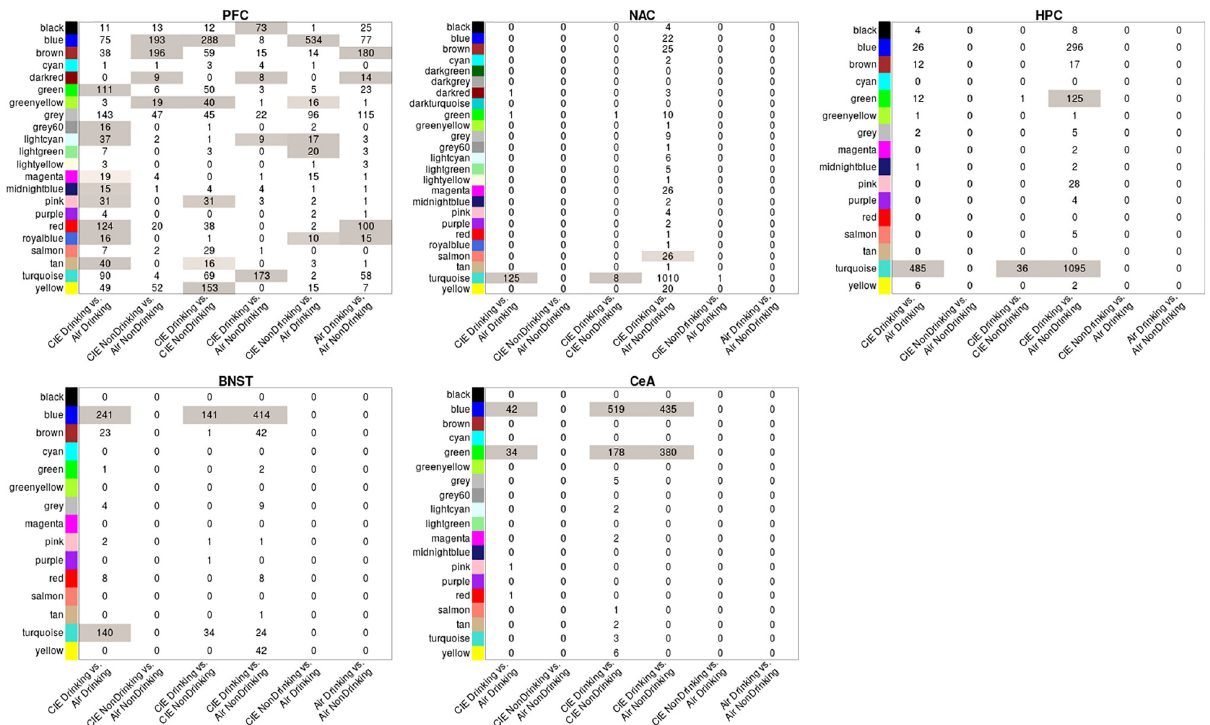
Fig 4. Overlap between WGCNA modules and all 6 treatment/drinking group comparisons in all brain-regions. Cell numbers indicate number of overlapping probesets between module and significantly differentially expressed genes for each comparison (LIMMA p-value � 0.05). Cell color indicates significant of overlap. Significant overlap: p-value �